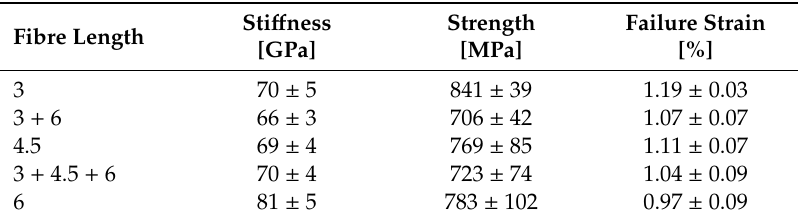
Table 1. Material property summary